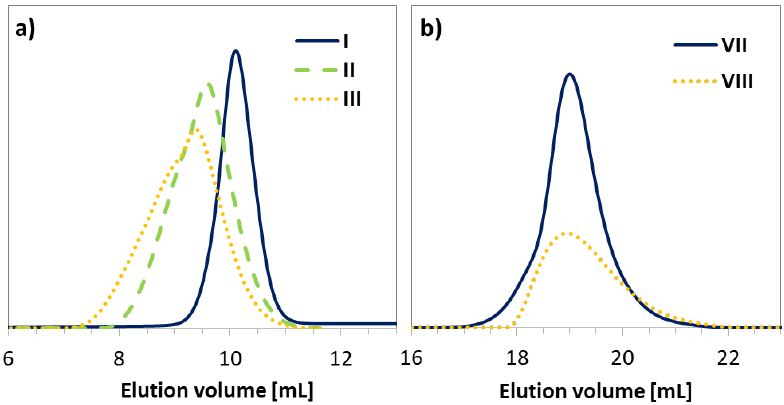
Figure 4. GPC traces for copolymers ( a ) P(AlHEMA- co -MMA) and ( b ) P(HEMA- co -MMA) .